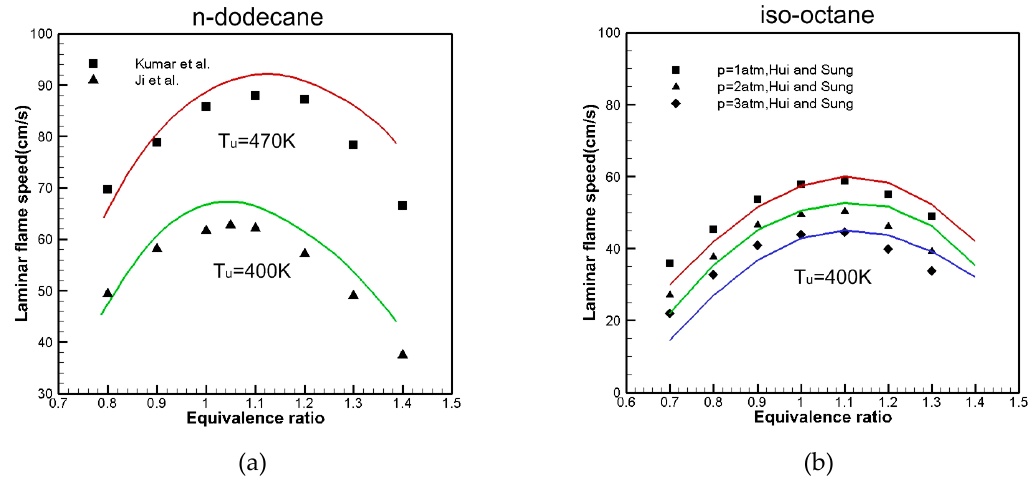
Figure 10. Comparison of the calculated (line) and measured (symbol) [16,29,30] of laminar flame speed with (a)n-dodecane and (b)iso-octane